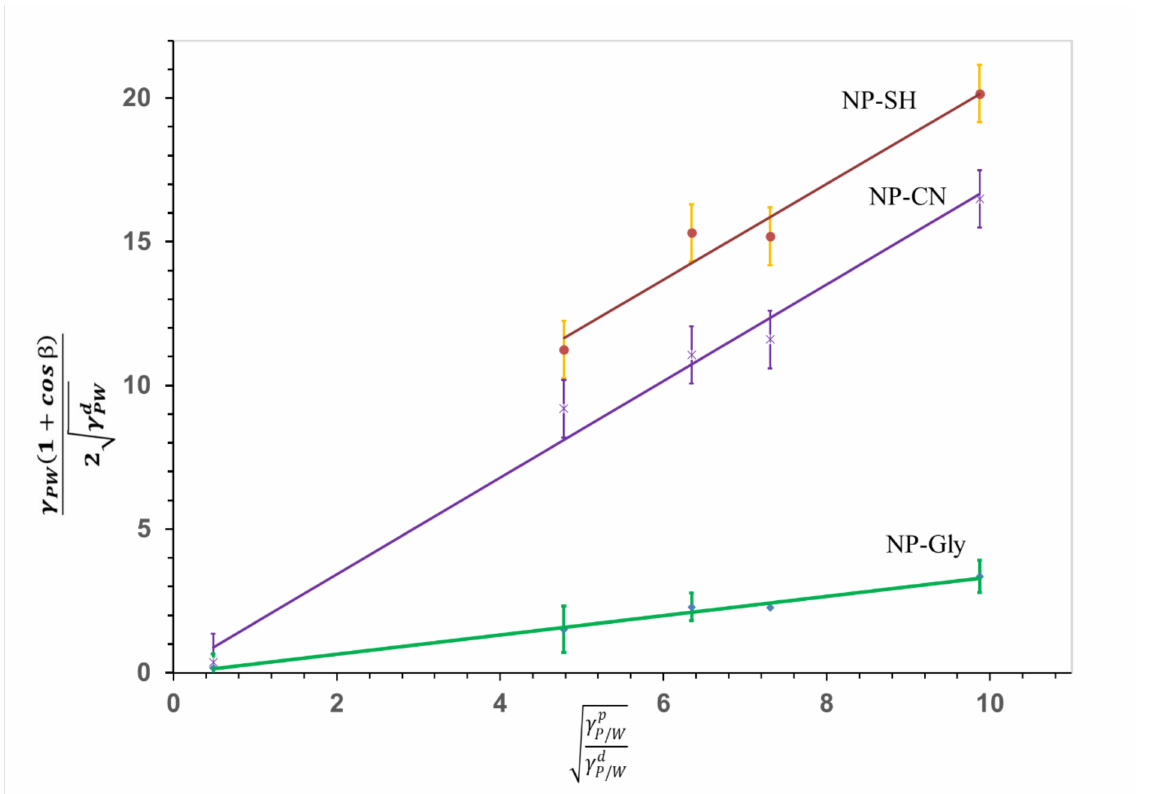
Figure 2. The graphical representation of the linearized OWRK Equation (1), constructed for NP-SH, (cid:113) γ p NP-CN, and NP-Gly. The slope is proportional to the polar component of the surface energy NP / W (cid:113) γ d of the NPs and the intercept is proportional to the dispersive component of the surface NP / W energy of the NPs. The data corresponding to NP-SH were offset by +3, for better visualization. The data for NP-SH, NP-CN were taken from reference